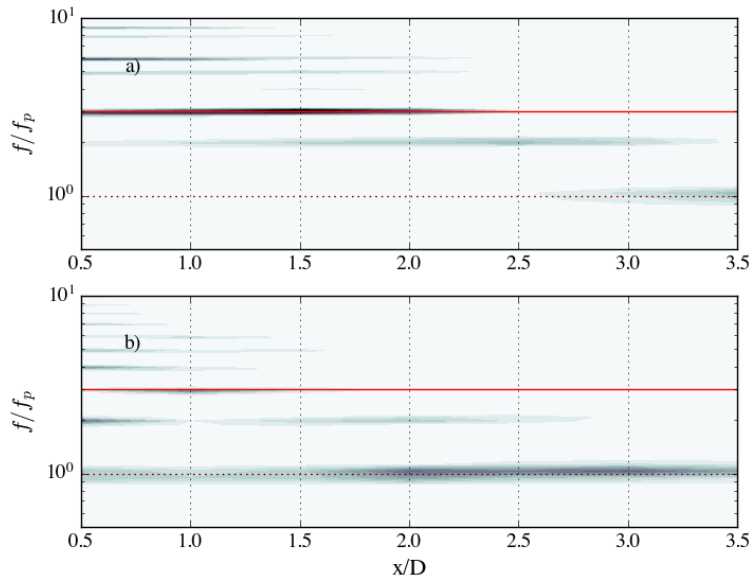
Figure 17. Pre-multiplied spectra of the experimental axial velocity, f P u ( f ) / σ 2 u , at y / D = 0 and along z / D = 0 for the balanced rotor ( a ) and unbalanced rotor ( b ). The frequency is normalised by the rotation frequency of the rotor: (dotted red line) rotor frequency, (solid red line) blade passage